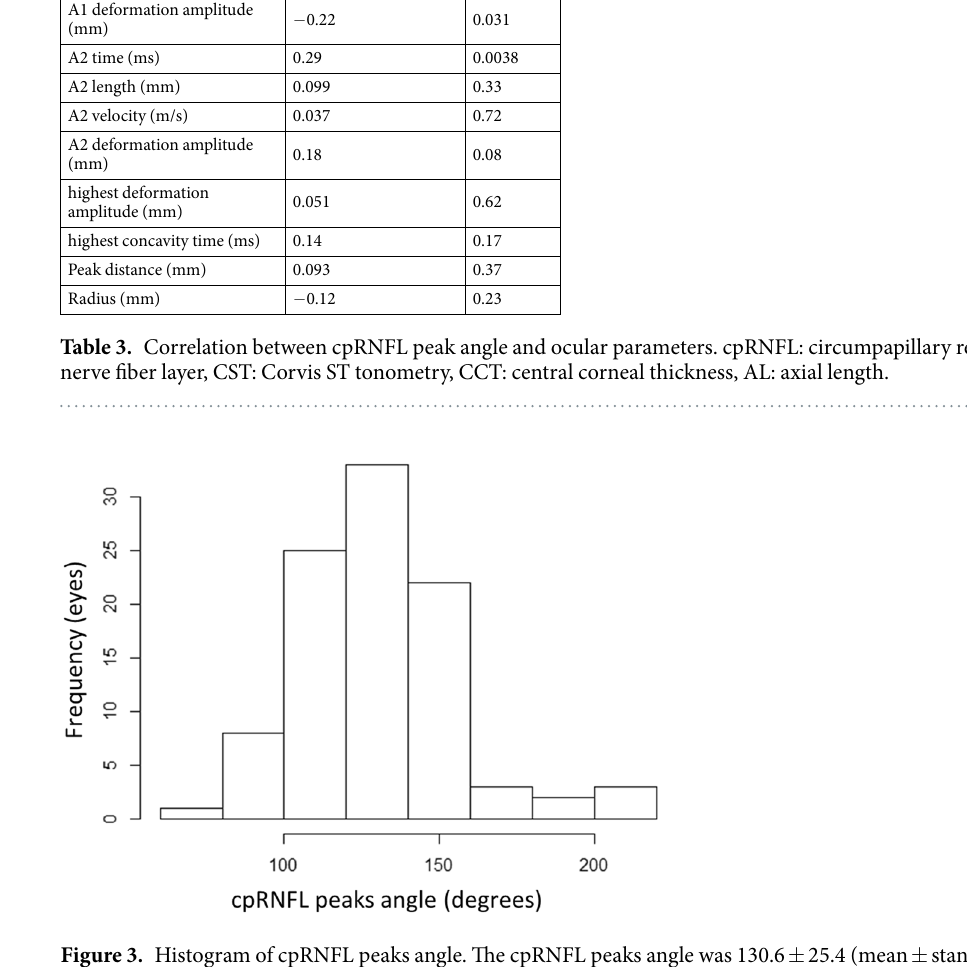
Figure 3. Histogram of cpRNFL peaks angle. The cpRNFL peaks angle was 130.6 ± 25.4 (mean ± standard deviation) [range: 77.8 to 207.0] degrees. cpRNFL: circumpapillary retinal nerve fiber layer.